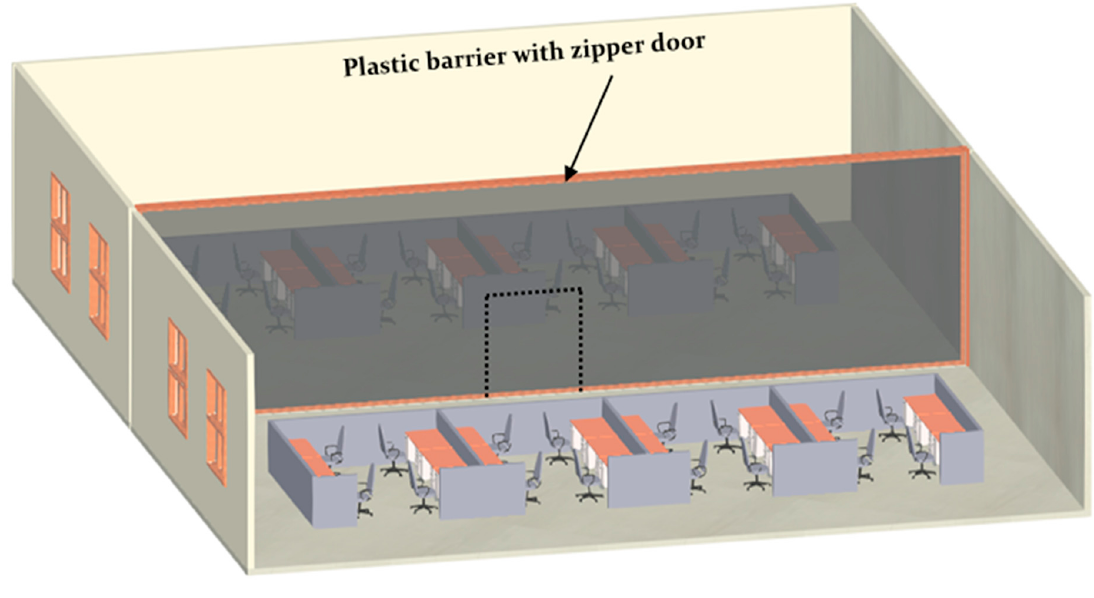
Figure 11. Separation of a large open space in an office building with a plastic barrier.